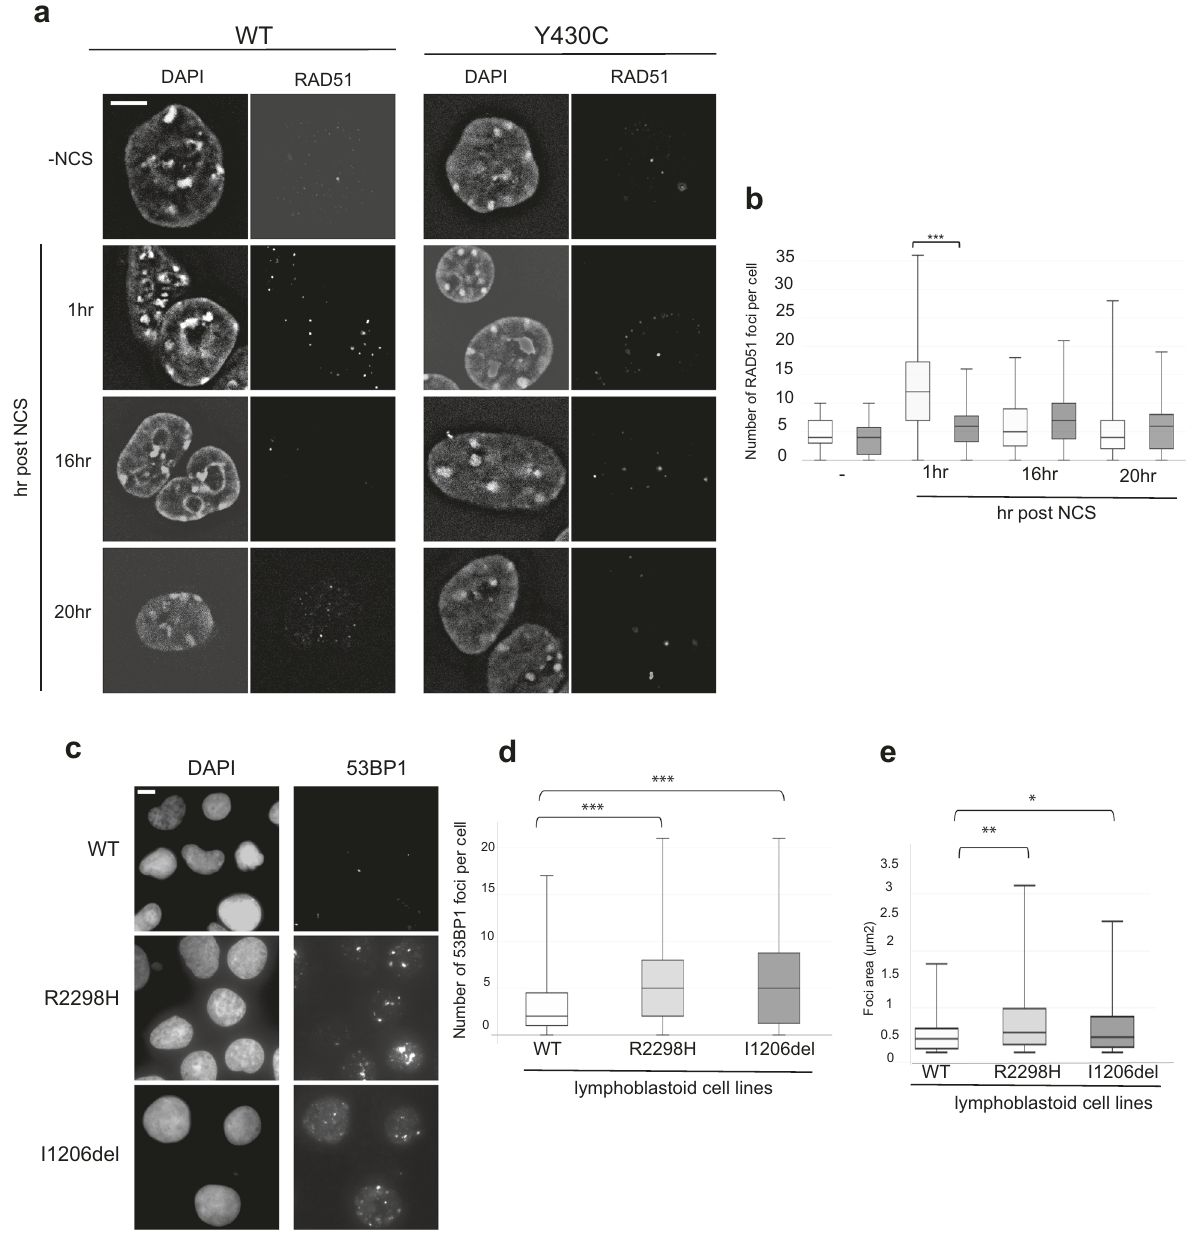
Fig. 6 Evidence for DNA repair defects in CdLS. Representative images of wild-type and Y430C mESCs upon RAD51 immuno fl uorescence and DAPI staining after treatment with NCS. Scale bar = 5 μ m. The experiment was repeated three times with similar results. b Box-plot shows number of RAD51 foci per cell, respectively, in WT and Y430C cells after treatment with NCS in one representative experiment. Horizontal lines within boxes show medians, boxes are inter-quartile ranges and whiskers are range. P -values were calculated with Mann – Whitney one-sided U test. *<0.05, **<0.01, ***<0.001. 50 cells were examined per condition. c Representative images of wild-type, R2298 and I1206del LCLs upon 53BP1 and DAPI immuno fl uorescence. Scale bar = 5 μ m. The experiment was repeated three times with similar results. d , e Box-plots show number of 53BP1 foci per cell and area of 53BP1 foci ( μ m 2 ), respectively, in WT, R2298H and I1206del LCLs in one representative experiment. Horizontal lines within boxes show medians, boxes are inter-quartile ranges and whiskers are range. P -values were calculated with Mann – Whitney one-sided U test. *<0.05, **<0.01, ***<0.001. 50 cells were examined per